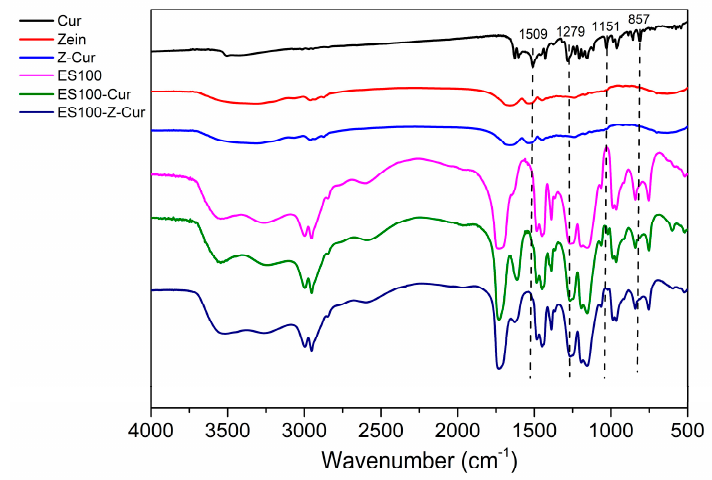
Figure 3. Fourier transform infrared spectroscopy of pure Cur, zein, released self-assembled Z–Cur, ES100, ES100–Cur, and ES100–Z–Cur.